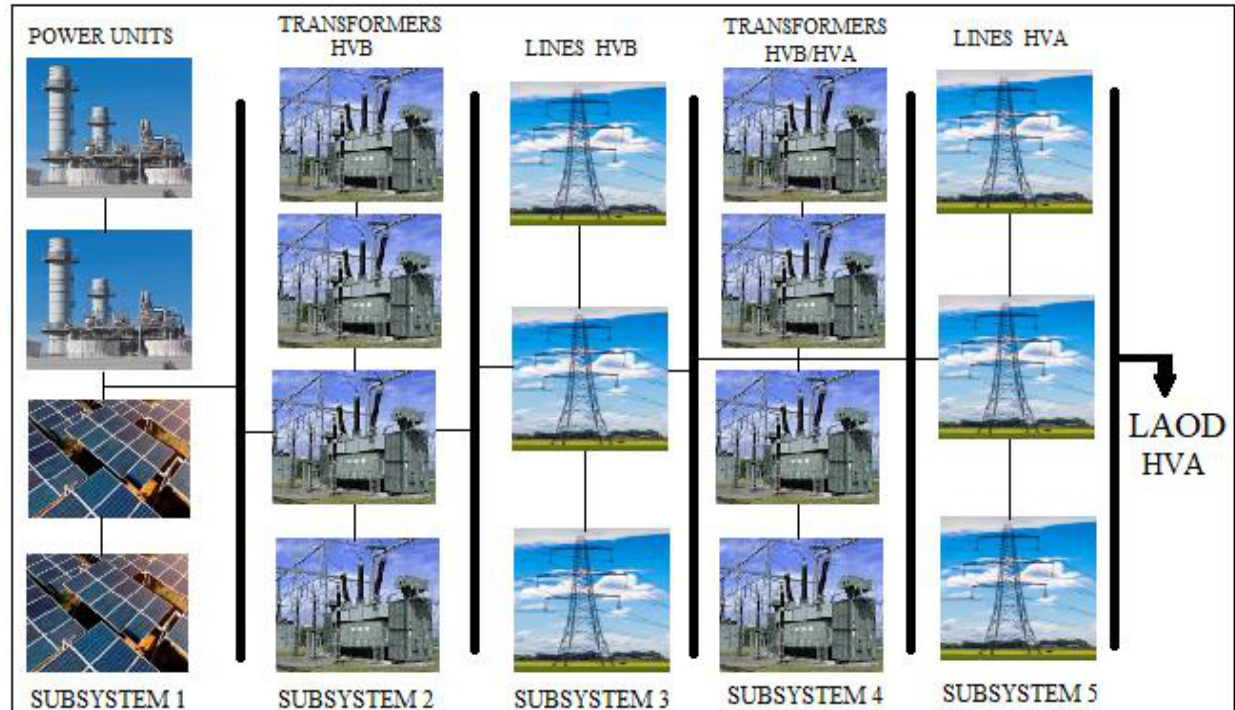
Figure 2. Series-parallel electro-energy system.